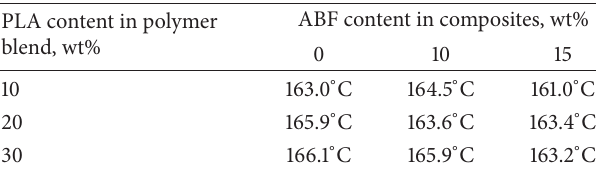
Table 5: 𝑇 𝑚 of PLA in polymer blends and composites.